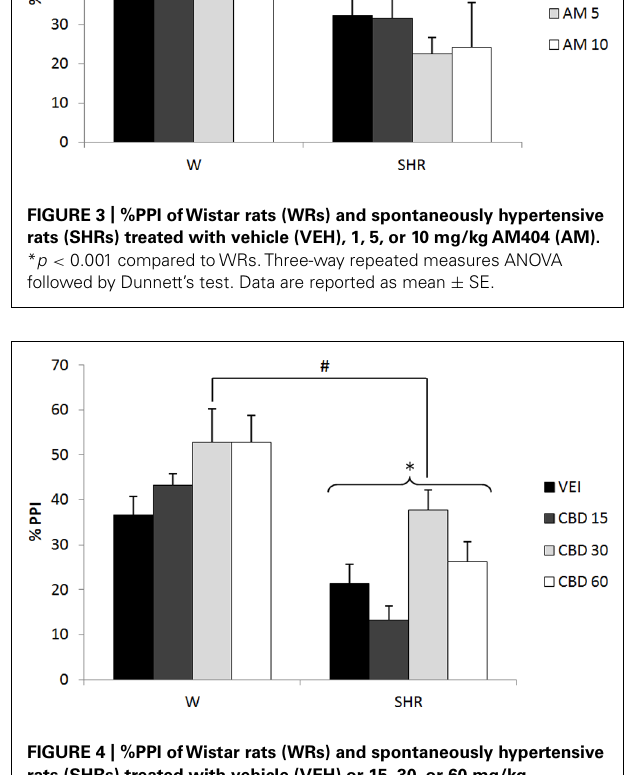
FIGURE 4 | %PPI ofWistar rats (WRs) and spontaneously hypertensive rats (SHRs) treated with vehicle (VEH) or 15, 30, or 60 mg/kg cannabidiol (CBD). * p < 0.001 compared toWRs. # p < 0.05 compared to VEH group.Three-way repeated measures ANOVA followed by Dunnett’s test. Data are reported as mean ±